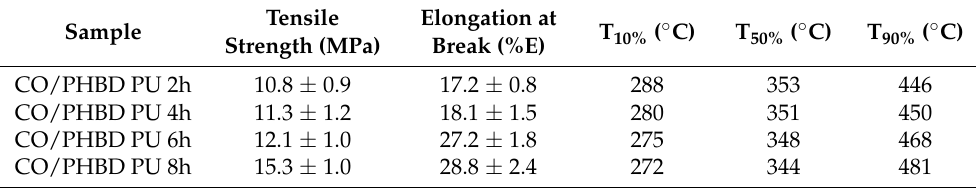
Figure 8. Stress vs. strain curves of the different CO/PHBD PUs. Table 3. Mechanical and thermal data for CO/PHBD PUs.